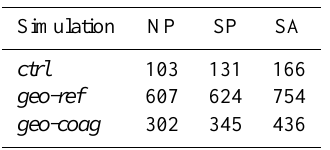
Table 4. Mean radiative flux perturbation (Wm − 2 ) for the geoengi- neered regions in North Pacific (NP), South Pacific (SP), and South Atlantic (SA) as shown in Fig. 6. The last column is the global mean value